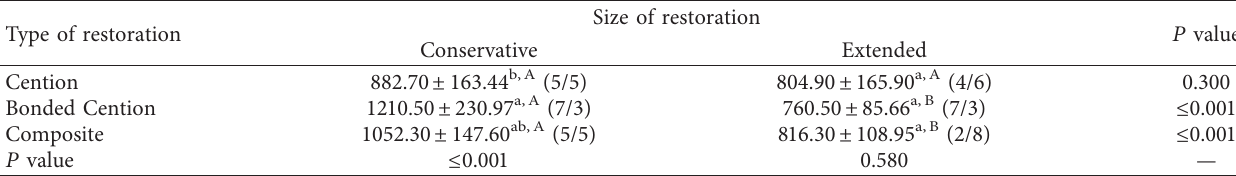
Table 1: Mean ± SD of fracture resistance (N) in the experimental groups and fracture pattern (restorable/nonrestorable).